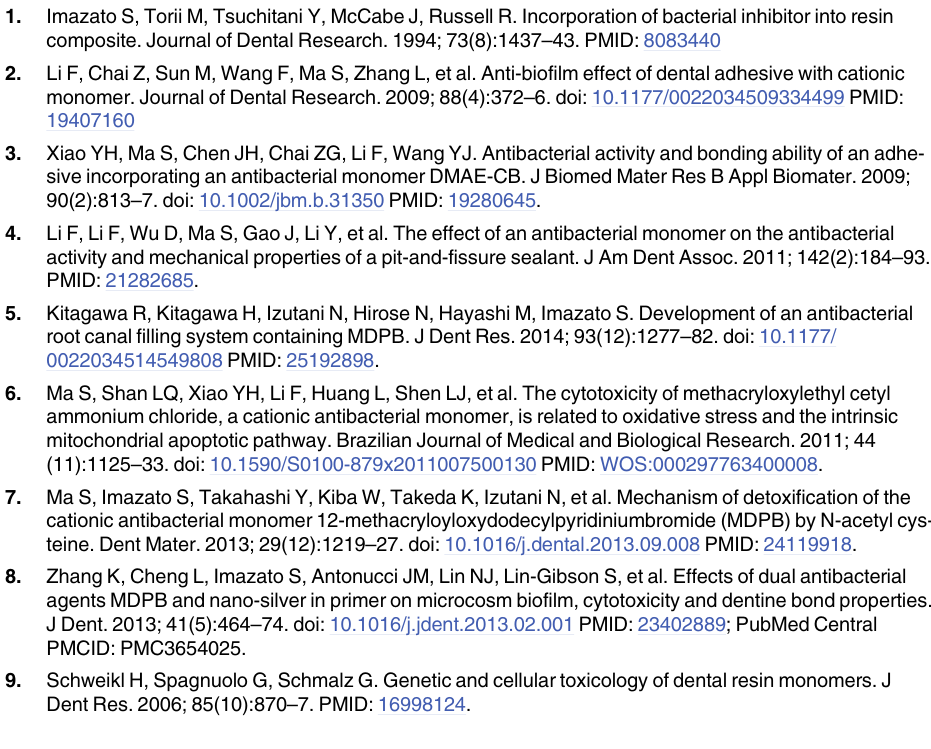
S1 Fig. Raw data. Graphs of high performance liquid chromatography, liquid chromatogra- phy-mass spectrometry and Hoechst 33242